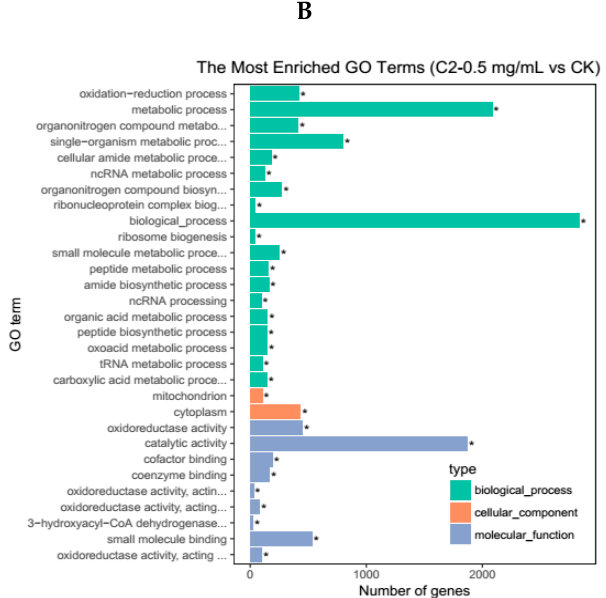
Figure 3. Functional annotation of differentially expressed genes using the gene ontology (GO) database. ( A ) C2-0.1 mg/mL vs. CK; ( B ) C2-0.5 mg/mL vs. CK.